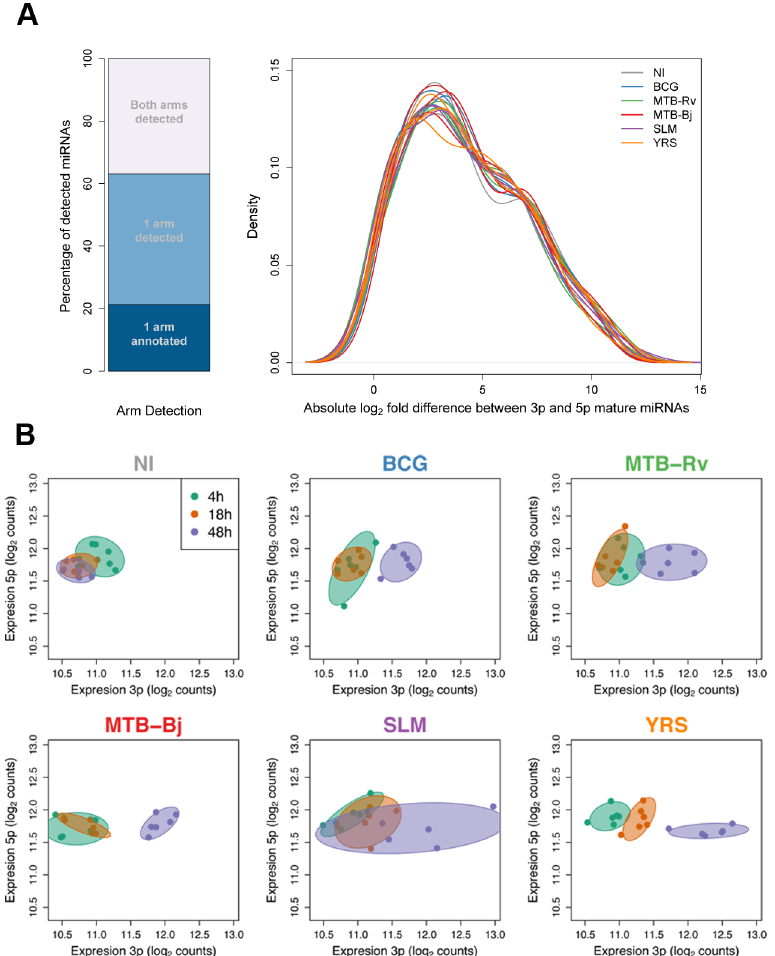
Fig 3. Changes in relative miRNA arm expression upon infection. (A) Detection and relative expression of miRNA hairpin arms. Stacked bar plot shows the proportion of detected miRNA hairpins for which either one or both mature miRNA sequences were detected. Density plot shows the distribution of log 2 expression ratios for hairpins where both arms were expressed. (B) An example of one miRNA, miR-361, which showed a strong infection-dependent change in relative arm expression. Axes show the expression of the 3p and 5p arms of all sequenced individuals at each time point. In each panel, colours denote the different time points, and infection conditions are plotted in separate panels. The displacement of points towards the right of the plot in infected samples at later time points shows that the change in the expression ratio of the two arms is due to the increased expression of the 3p arm that, in some conditions, becomes